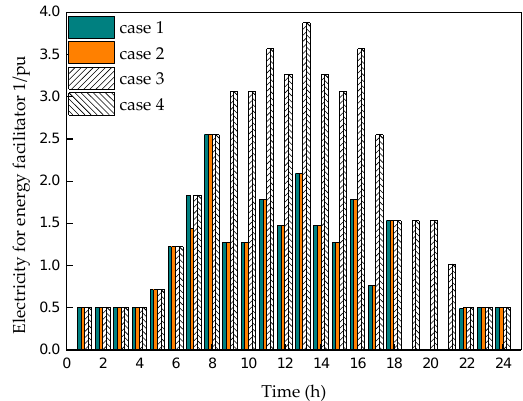
Figure 9. Electricity supply from electricity network.